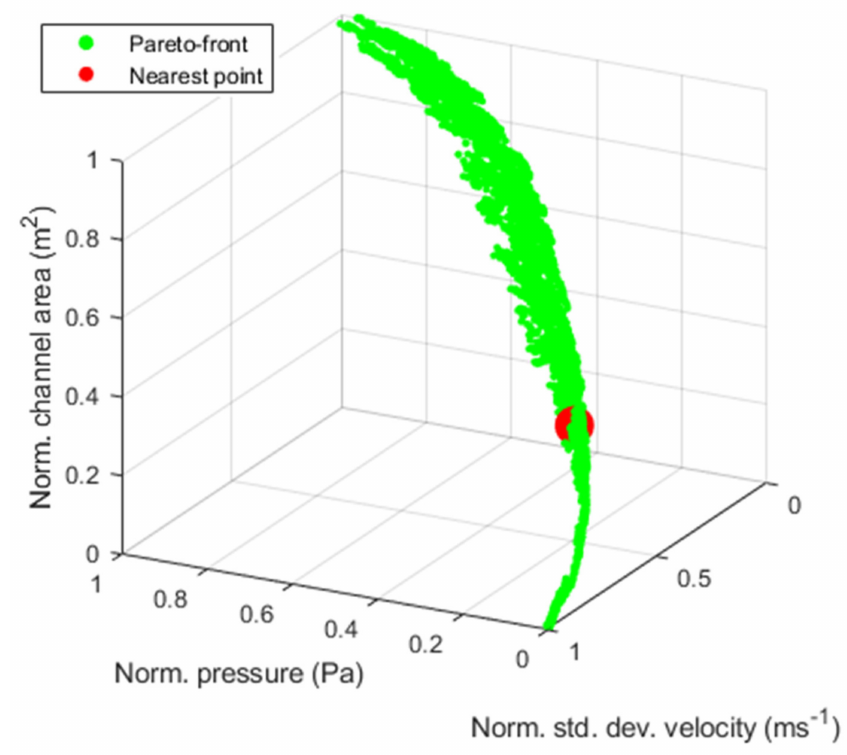
Figure 14. Non-dominated front with normalized objectives and nearest